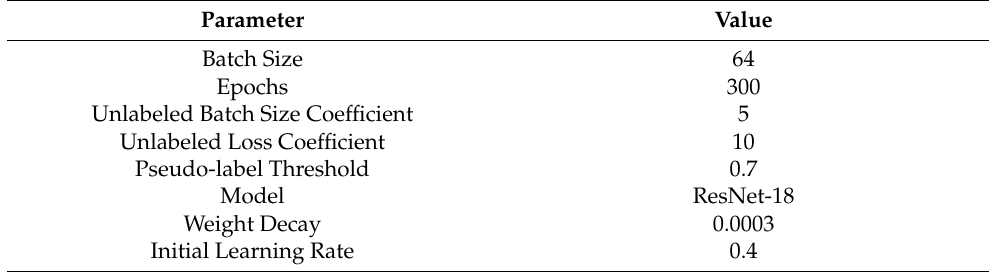
Table 5. Training